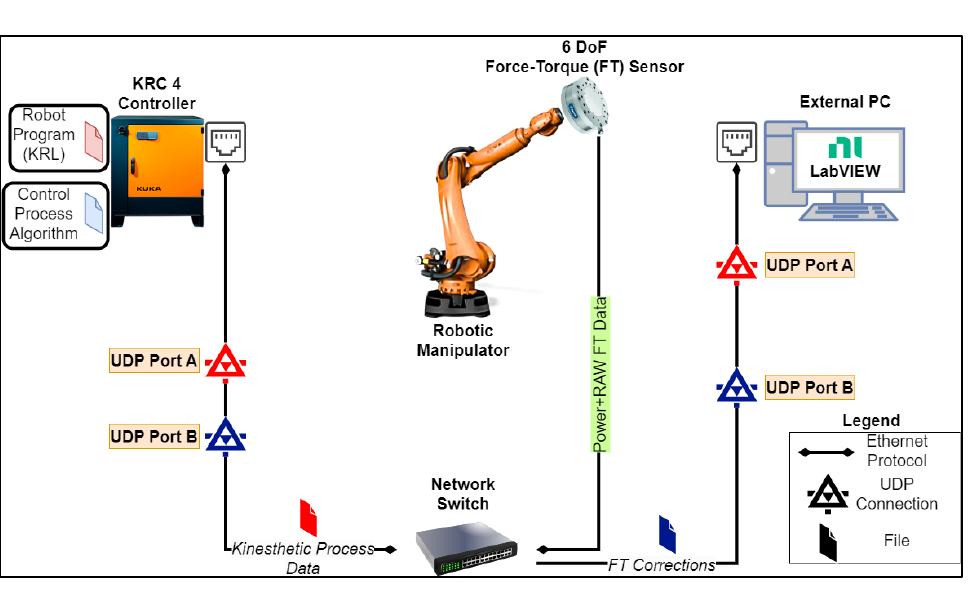
Figure 2. Communication interface for kinesthetic guidance and real-time kinematics generation based on the RSI protocol between external PC, KRC, and FT sensor. The external target updates , cyclically , the control process algorithm in the KRC4 controller .